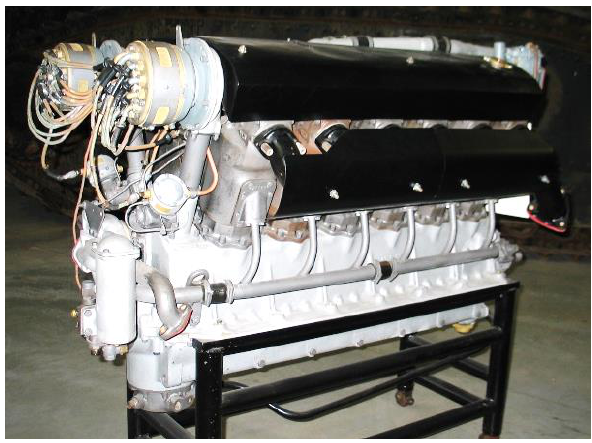
Fig. 2. The Liberty V-12 engine to power tanks (The Tank Museum at Bovington Camp in Dorset, photo by the author)